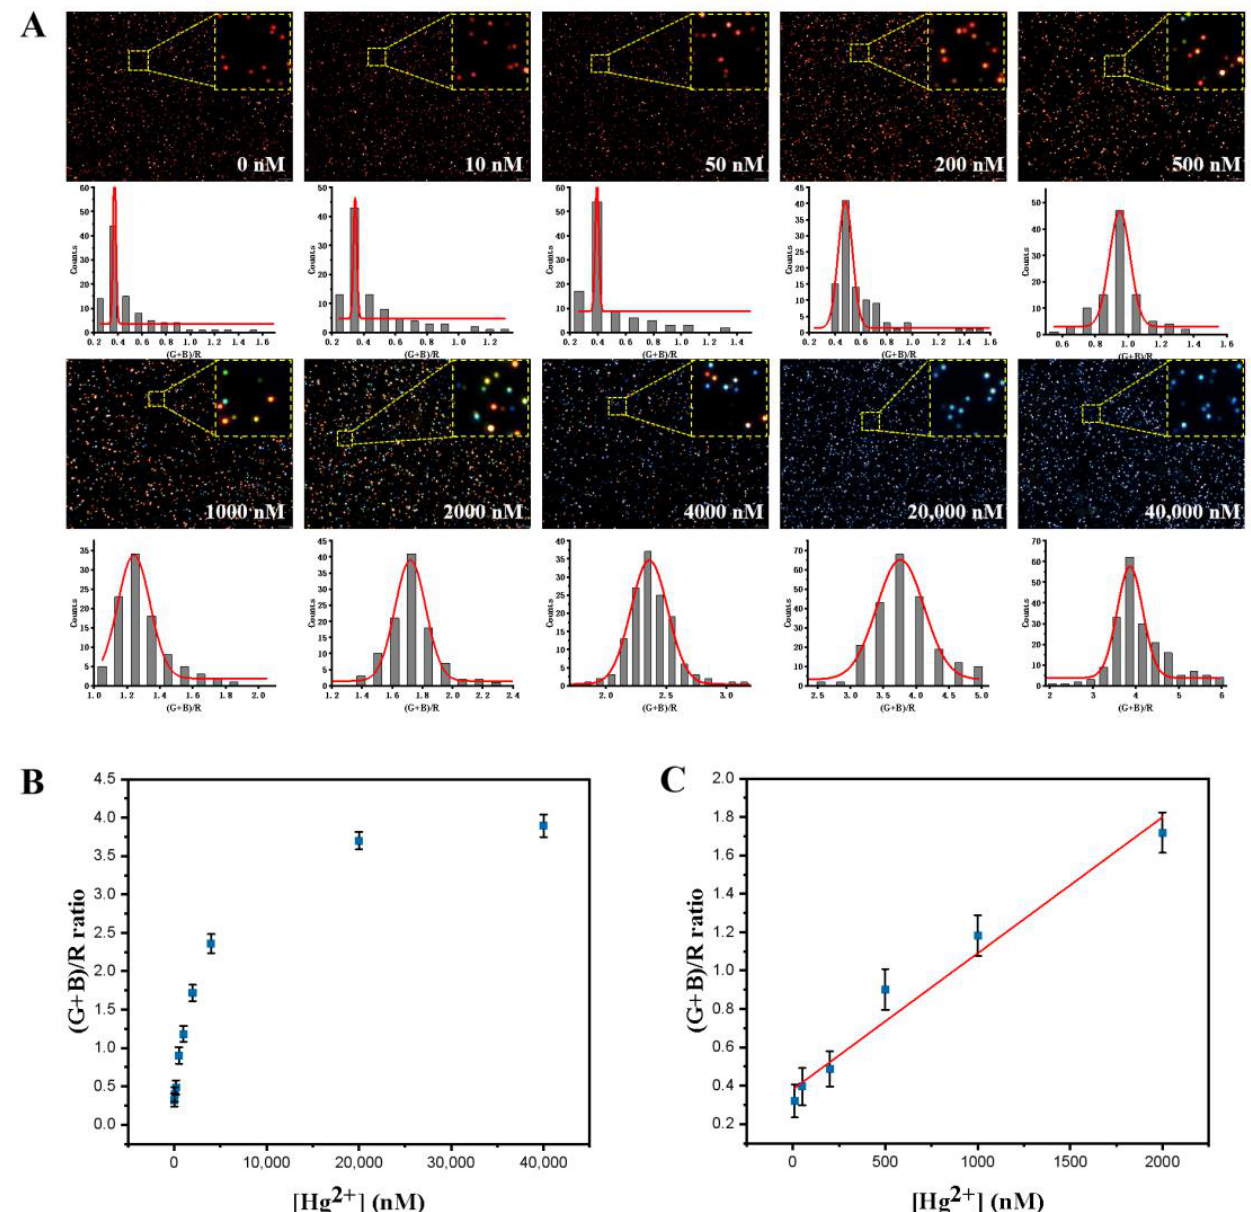
Figure 5. ( A ) DFM images of concave cube Au nanoparticles with the increased Hg 2+ concentrations over the range of 0–40,000 nM and the corresponding Gaussian fitting of (G+B)/R ratio. ( B ) (G+B)/R ratio dynamic range vs. Hg 2+ concentration over the range of 0–40,000 nM and ( C ) a linear relationship with Hg 2+ over 0–2000